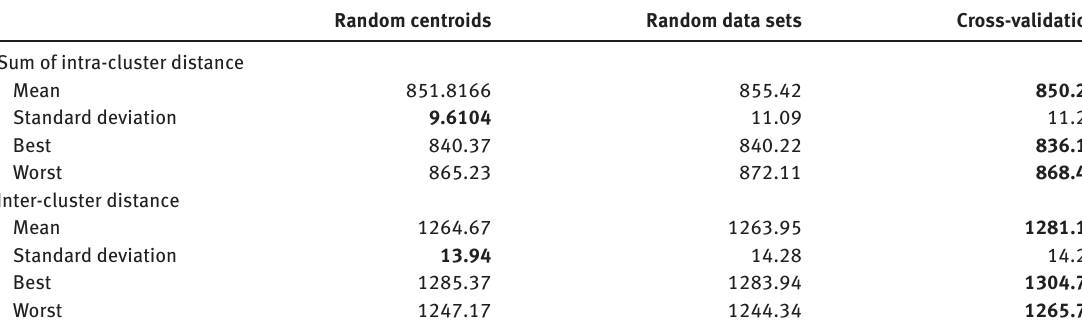
Table 6: Cross-Validation of Ruspini Data Set: